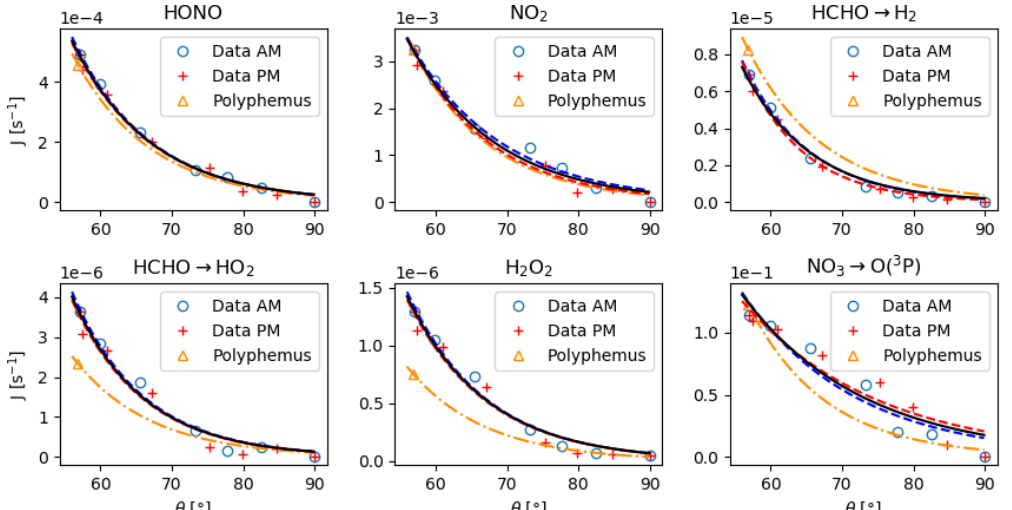
Figure 4. Photolysis rates as a function of zenith angle. The symbols (cid:13) and + denote the experimental rates acquired on 30 October in the morning and in the afternoon. The blue and red dashed lines are their parameterization using Eq. (32). The black solid line is the curve obtained by fitting the data from both the morning and those from the afternoon. The (cid:52) symbols are the photolysis rates calculated with Eq. (31) with the cross sections and quantum yields taken from Polyphemus. The yellow dash-dotted line is the deriving evolution of J with θ according to Eq. (34).